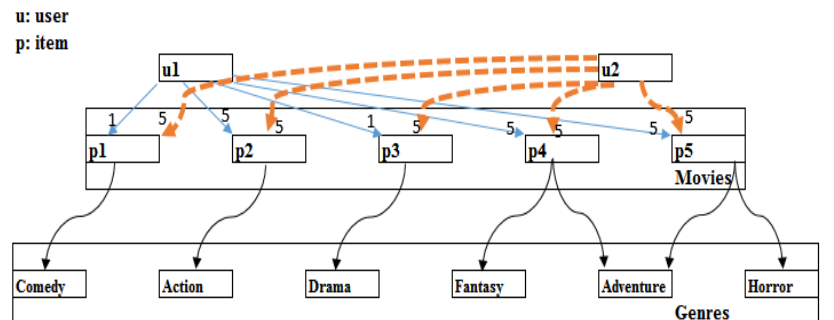
Figure 1. Example of user preferences for movie genres.